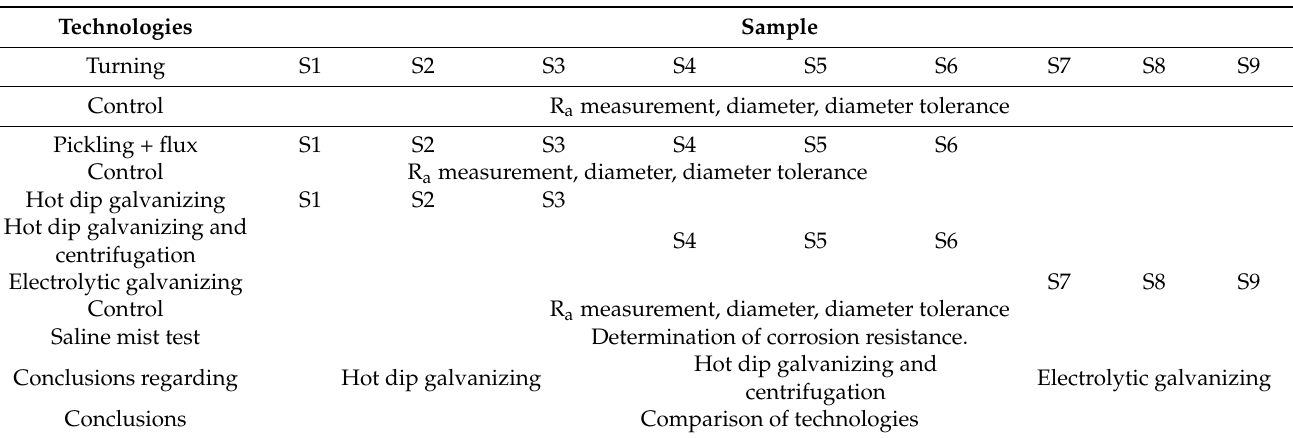
Table 2. Gantt chart of